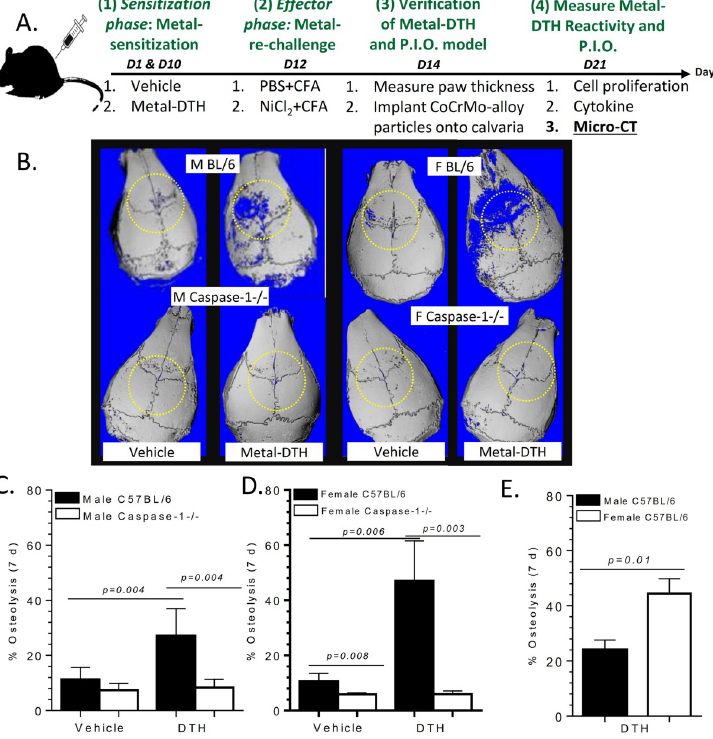
Fig 6. A pre-existing condition of metal-DTH augments metal particle-induced osteolysis. (A) Schematic model demonstrating experimental design where both vehicle and metal-DTH treated male and female C57BL/6 and Caspase-1 -/- mice received 2 mg/mouse calvaria of endotoxin-free CoCrMo-alloy particles. 7 days post-particle implantation (on day 21), calvaria were retrieved and analyzed by microCT. (B) Representative images and graphical representation of the percentage of particle-induced osteolysis from vehicle and metal-DTH treated (C) male and (D) female BL/6 and Caspase-1 -/- mice. (E) Comparison of percentage of bone loss from metal-DTH treated male vs. female BL/6 mice. Data represents two independent experiments with n = 4–5 mice/group in each experiment. Data are shown as the mean ± SEM. Statistical significance was determined by unpaired Mann-Whitney test.